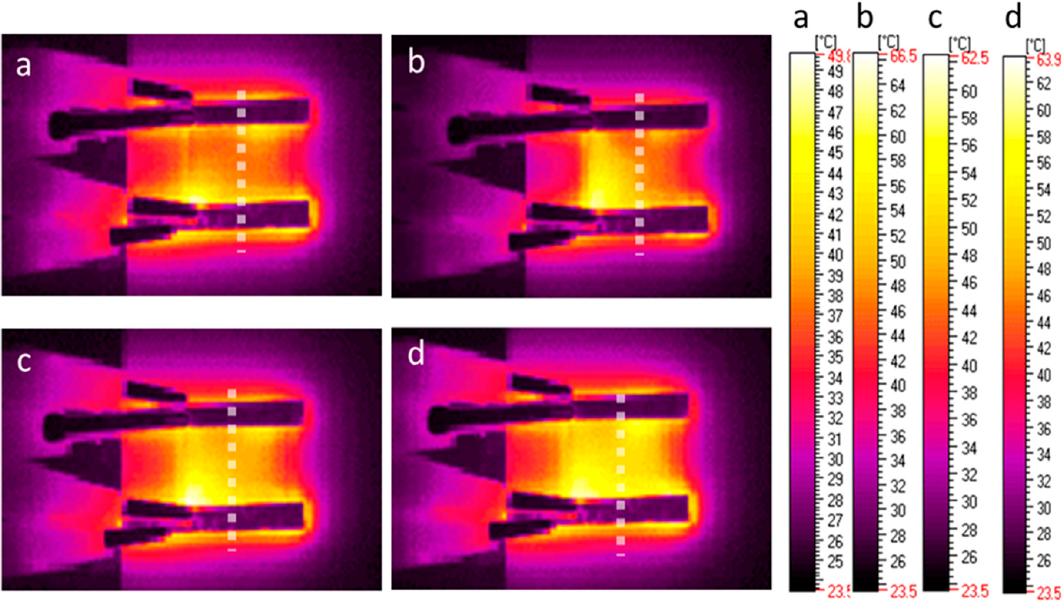
Figure 12. IR images obtained for L , D -PLA with 5% SWCN under different potential values: 9 V, 0.13 A, 6 min ( a ); 9 V, 0.2 A, 7 min ( b ); 9 V, 0.17 A, 8 min ( c ); and 9 V, 0.02 A, 9 min ( d ); after mechanical deformation.